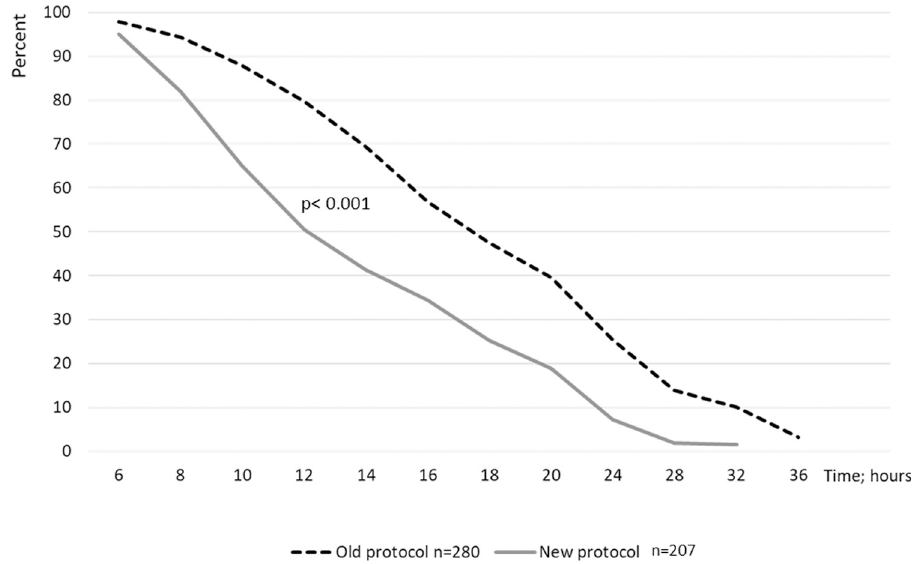
Fig 2. Duration of oxytocin induction in the old and new